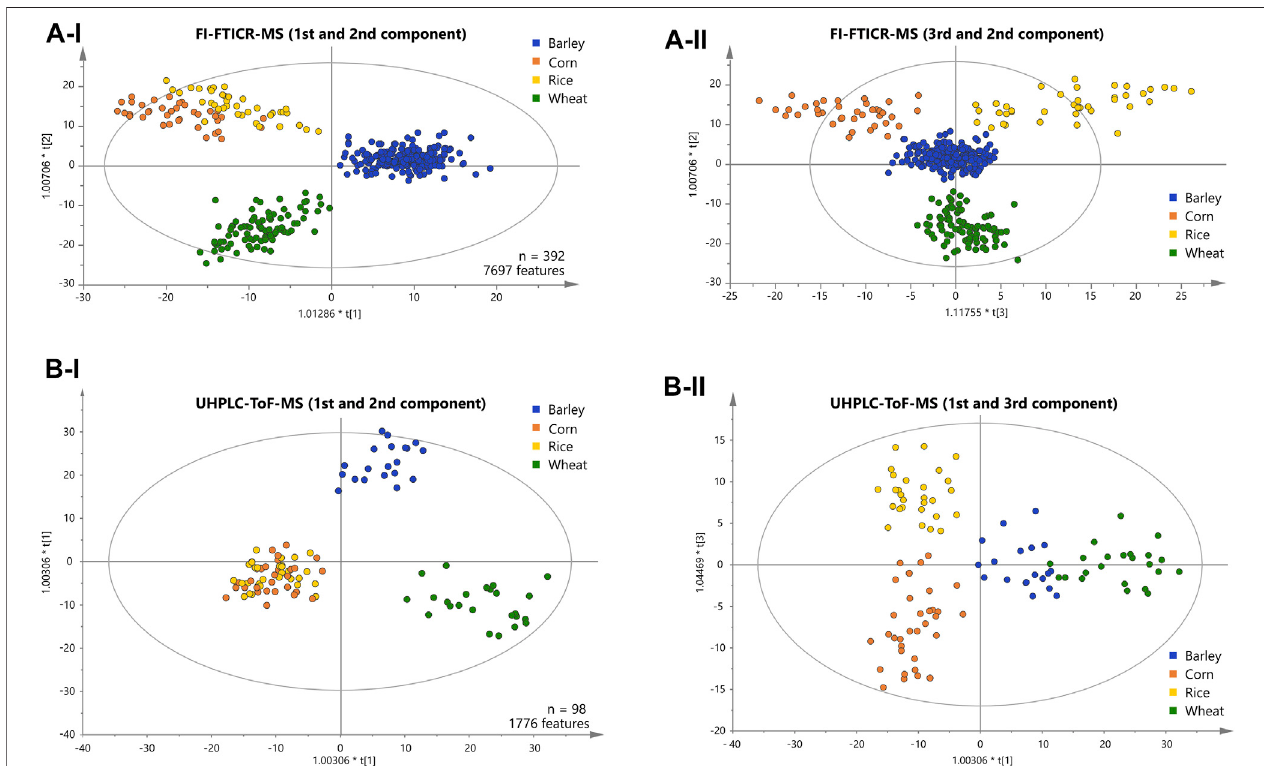
FIGURE 2 | Score plots of the OPLS-DA of the FI-FTICR-MS (A) and UPLC-ToF-MS (B) data differentiating the carbohydrate sources used. The position of the beer samples is marked by dots colored according to their carbohydrate source. The fi rst and second components are shown in (A-I) and (B-I) . The third against the second and the fi rst against the third component are shown in (A-II) and (B-II) respectively.